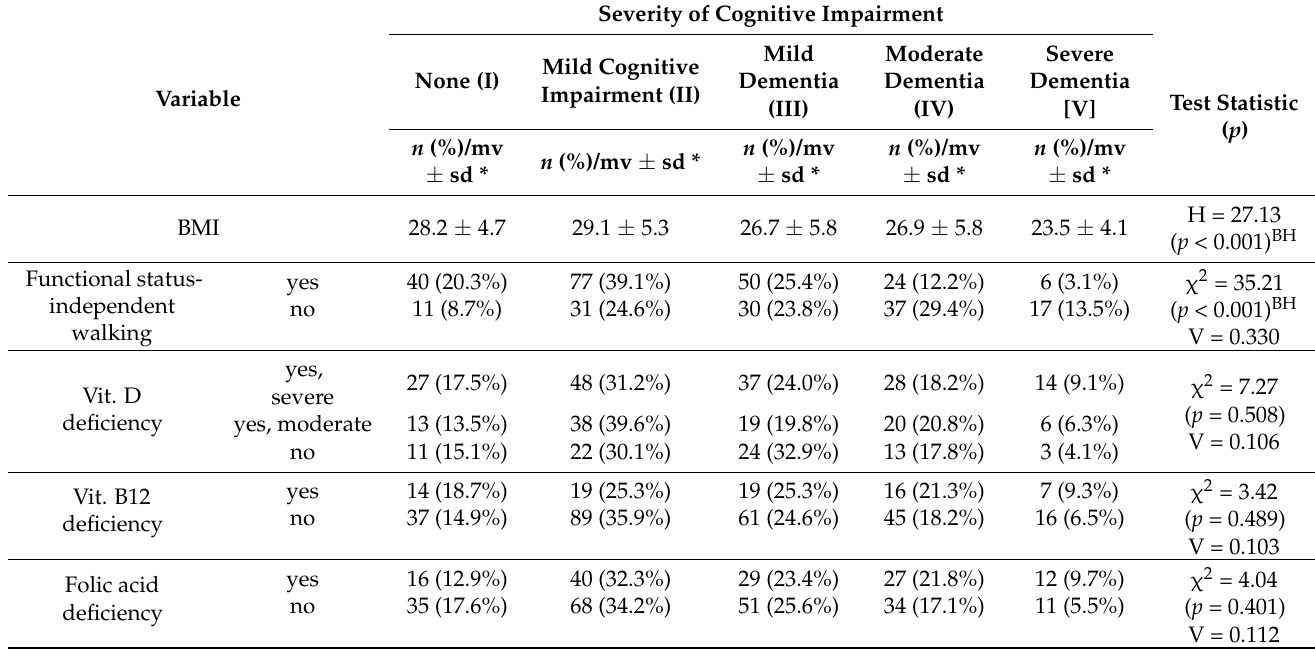
Table 4. Associations between selected health-related factors and severity of cognitive impairment.